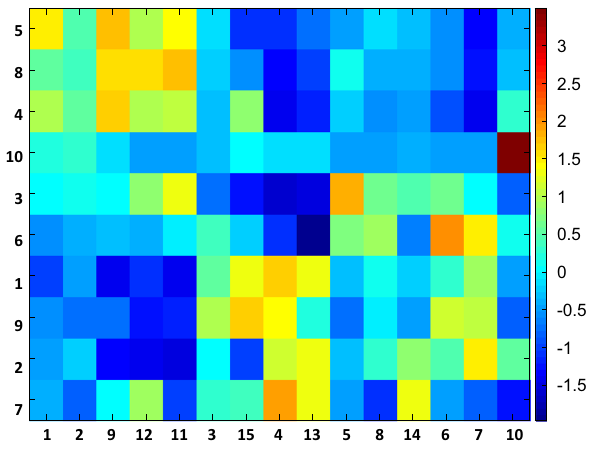
Fig. 4 Colour interpretive map of the oxide composition of ash